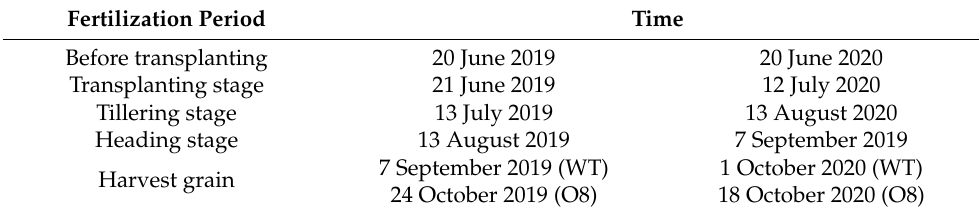
Table 1. Timetables of cultivation during the rice growing